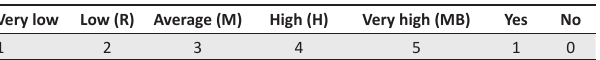
TABLE 6: Evaluation